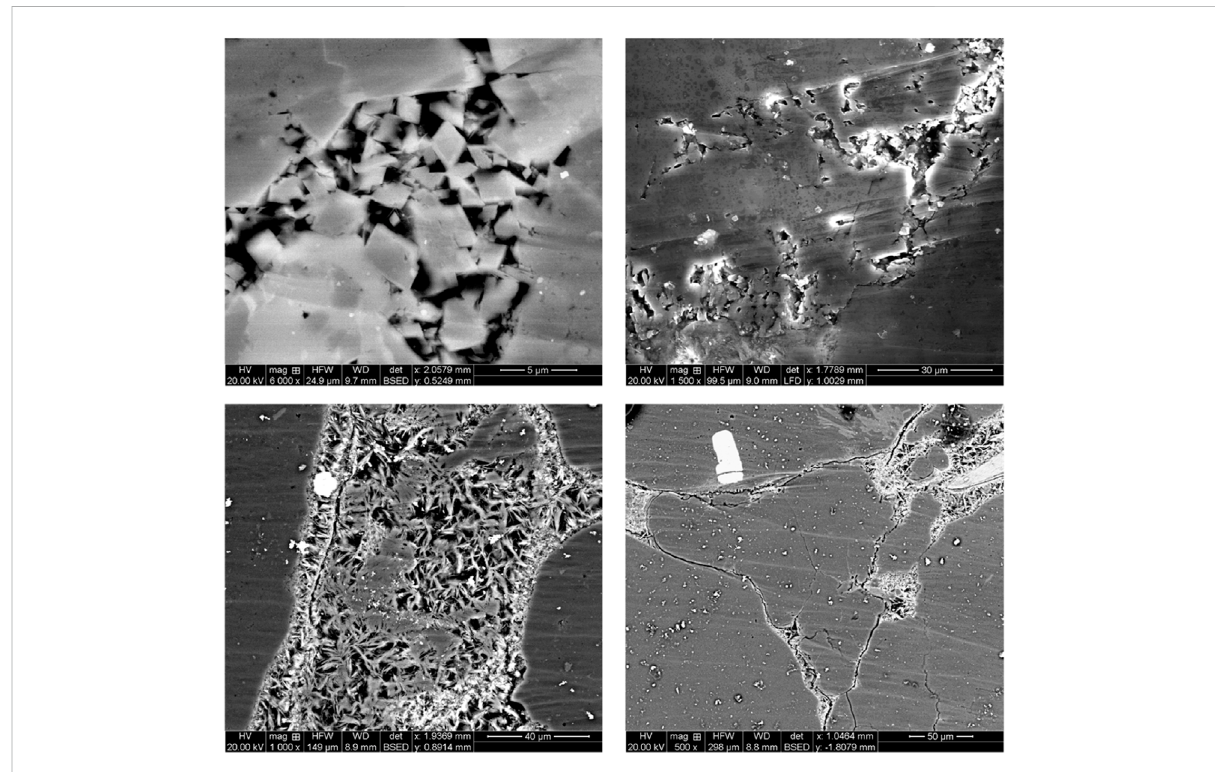
FIGURE 1 The SEM images of the second member of Yuanba Xujiahe gas reservoir.